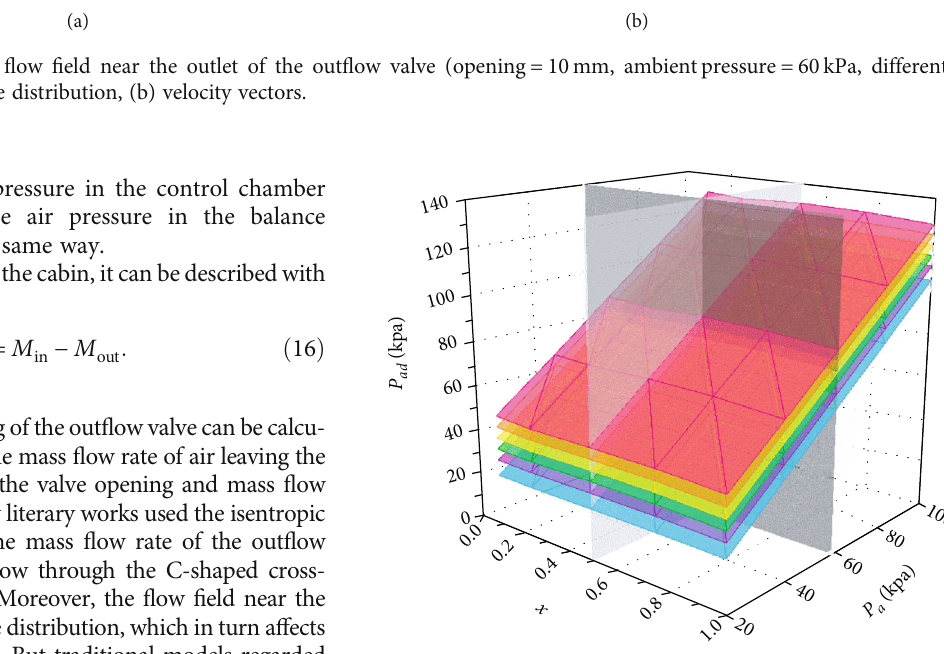
ad with relative